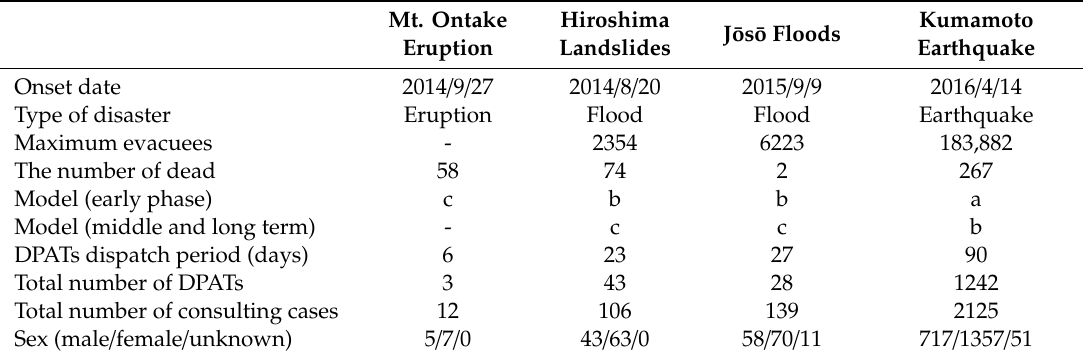
Table 1. Aggregated data on damage situations and DPAT activities for the four disasters.